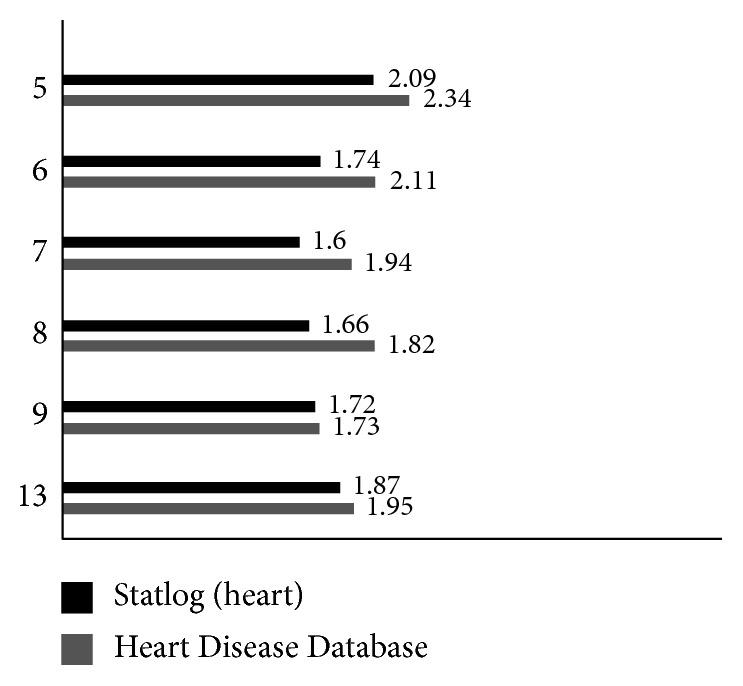
Reconstruction error of RBM1 with different number of hidden units.